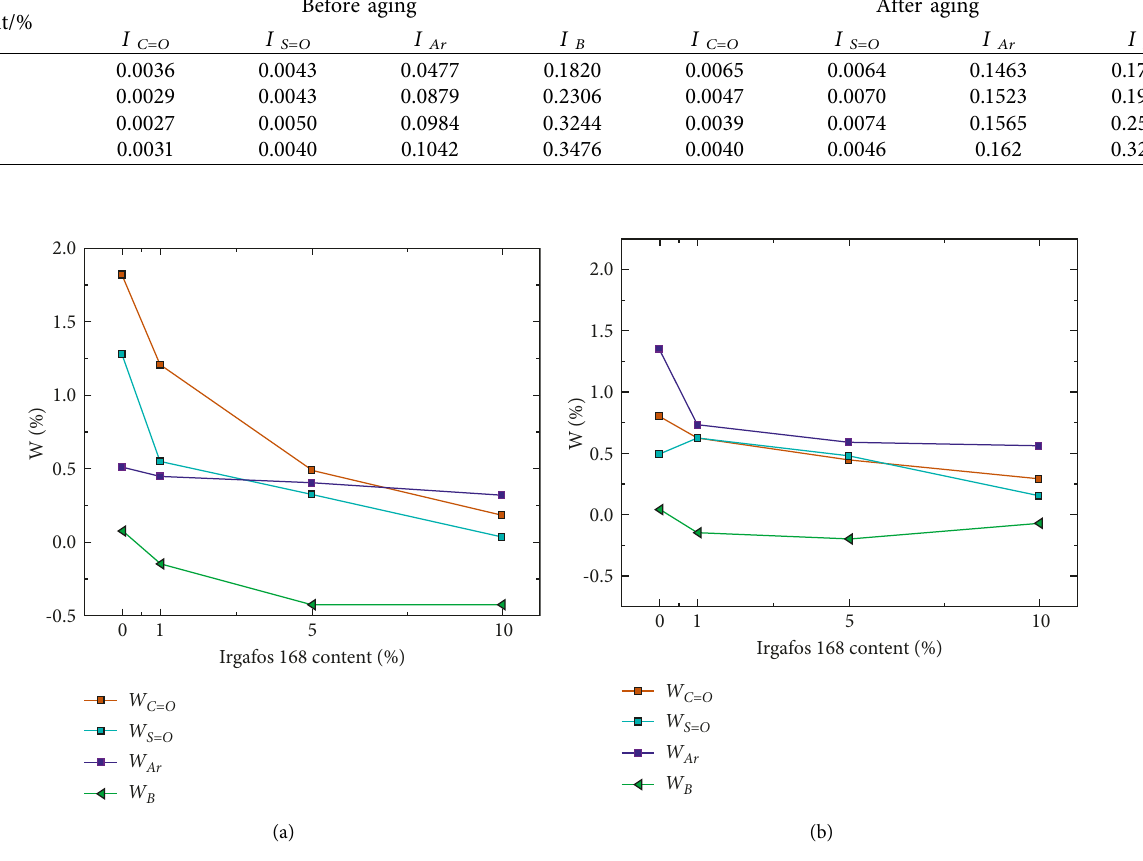
Figure 17: Effect of different Irgafos 168 contents on W of modified antiaging asphalt. (a) 2#. 4#.